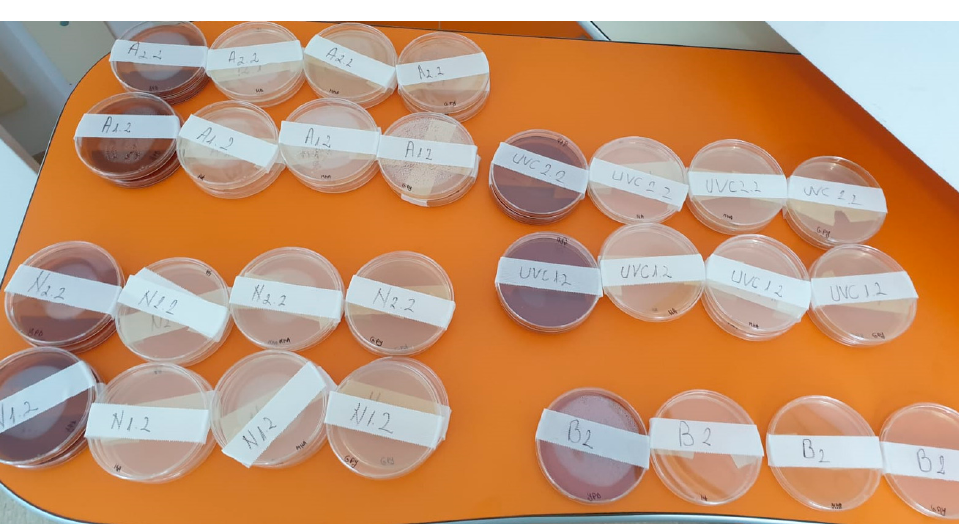
Figure 4. All the Petri dishes used for the test, labeled